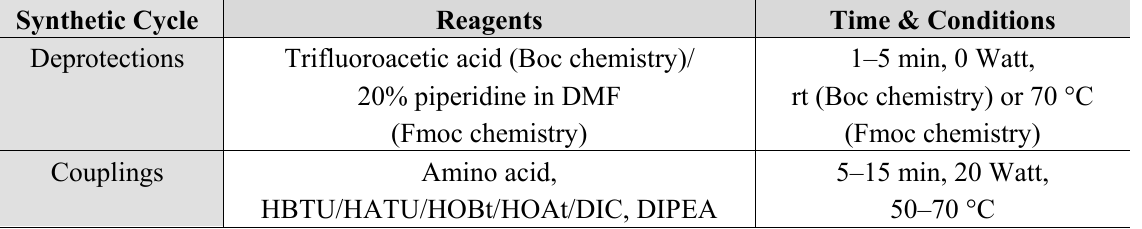
Table 2. In situ neutralization (optimized) protocol for microwave-SPPS